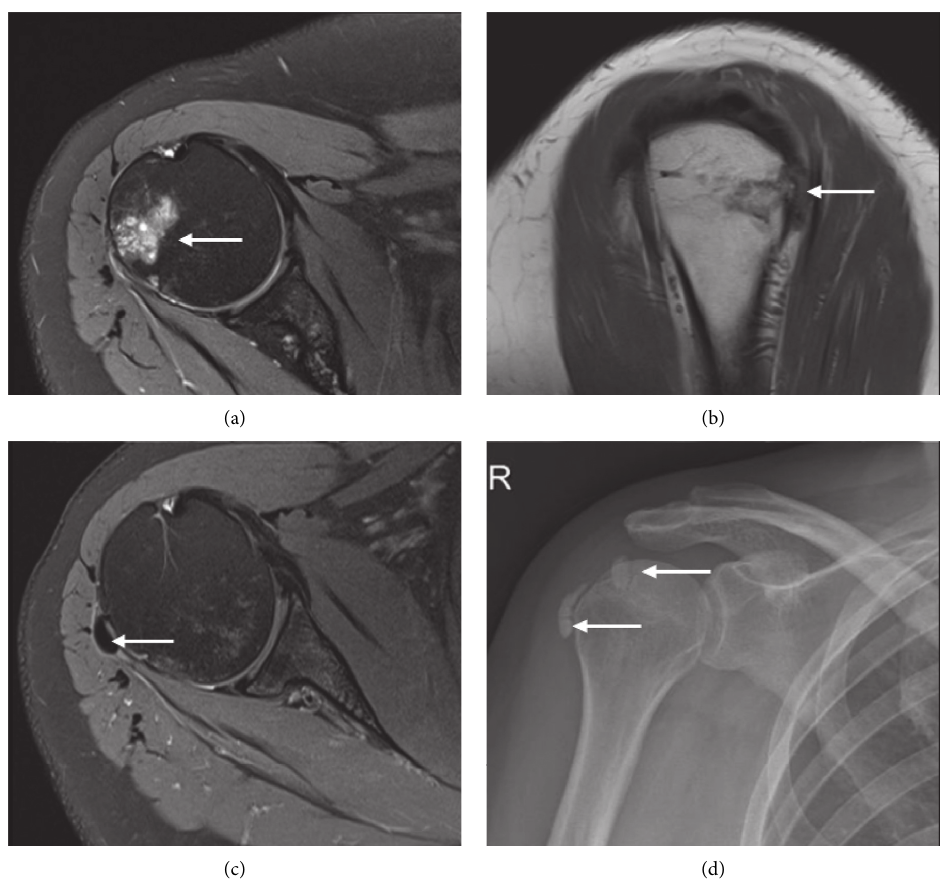
Figure 22: Calcific tendinitis in a 40-year-old female presenting with persistent shoulder pain. Axial PDFS (a) demonstrating marrow oedema signal in the humeral head at the greater tuberosity at teres minor tendon footprint. Sagittal PDFS (b) demonstrating corresponding cortical erosion. The MRI performed 5 months previously at the comparable plane (c) showed globular hypointense structure within the teres minor tendon footprint (arrow), confirming intraosseous migration of the calcific tendinitis in the most recent images. AP radiograph of the right shoulder (d) performed at the time of initial presentation also demonstrated calcium deposition in rotator cuff tendons. The calcium deposit is not well appreciated in the more recent study given the acute resorptive